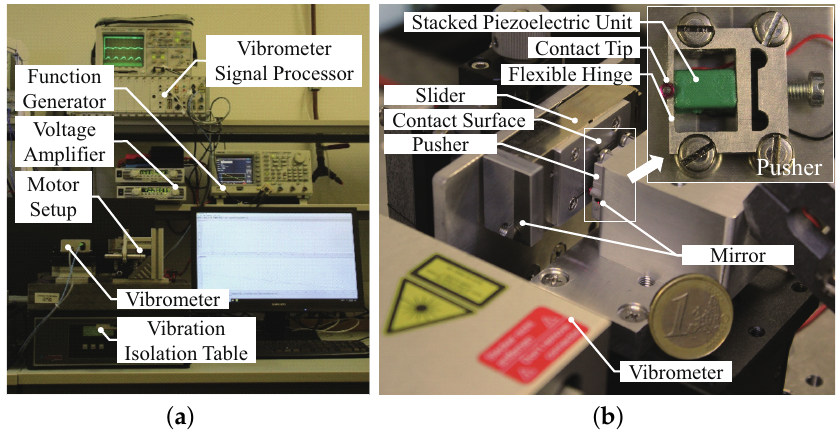
Figure 6. Experimental setup including the motor prototype. ( a ) Overall view of the experimental setup system; ( b ) Detail view of the motor prototype including the